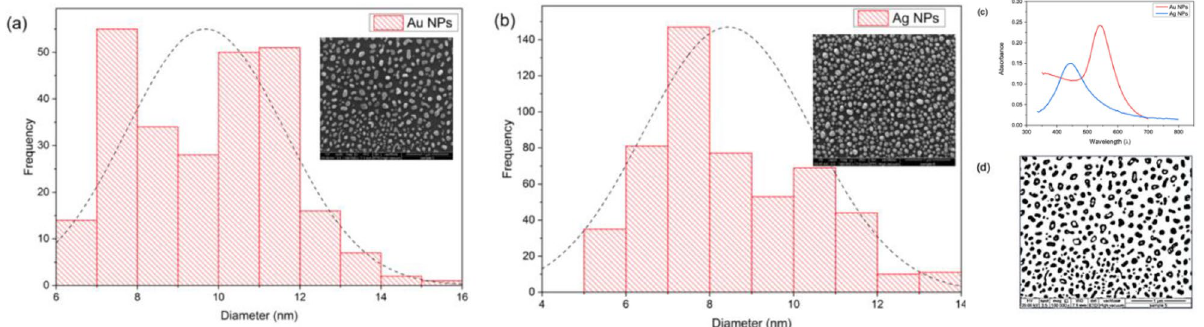
Figure 2. The SEM images and their respective histograms showing size of the nanoparticles with inset images as ( a ) Au NPs ( b ) Ag NPs ( c ) UV–Vis absorption spectra and ( d ) image-J particles